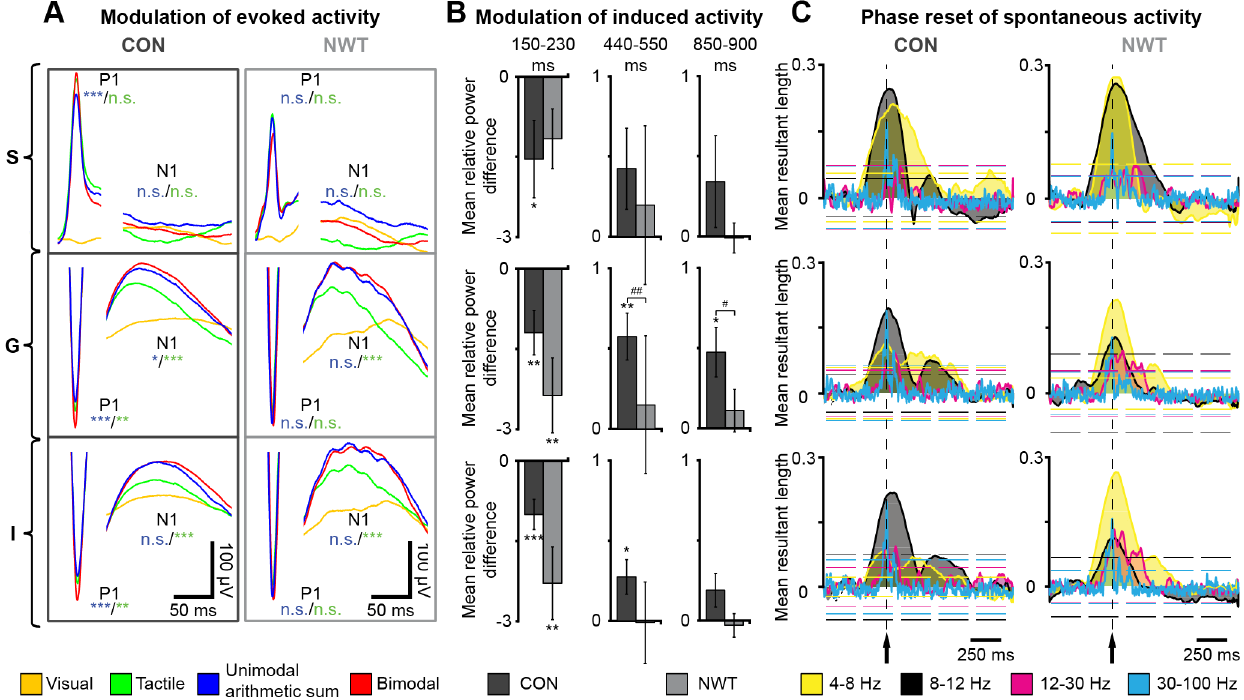
Fig 3. Cross-modal modulation of evoked and induced S1 network activity and visual phase reset of ongoing oscillatory activity in the S1 of CON and NWT rats. ( A ) Averaged potentials evoked by tactile (green), visual (orange), and bimodal (red) stimulation as well as the arithmetic sum of tactile and visual responses (blue) in the supragranular (top), granular (middle), and infragranular layers (bottom) of S1 in CON (left) and NWT rats (right). The first peak with positive surface polarity (P1) and the first negative peak (N1) are displayed. Significance values (not significant [n.s.], p < 0.05 [ * ], p < 0.01 [ ** ], p < 0.001 [ *** ]) correspond to the comparison of peak amplitudes between stimulation conditions (arithmetic sum of unimodal evoked responses versus congruent bimodal responses [blue]/tactile responses versus congruent bimodal responses [green]). ( B ) Bar diagrams displaying the mean relative power difference in gamma frequency range between bimodal and unimodal stimulation when calculated during different time windows post-stimulus in the S (top), G (middle), and I (bottom) layers of S1 in CON (black) and NWT rats (gray). Significance values correspond to the comparison between uni- and bimodal stimulation conditions ( * ) as well as between CON and NWT rats (#). ( C ) Plots displaying the mean resultant vector length of oscillatory phases in S1 of CON (left) and NWT rats (right) after contralateral visual stimulation (dotted line, black arrow). The values were averaged over time and layers in all CON and NWT rats for four distinct frequency bands: theta (4 – 8 Hz) in yellow, alpha (8 – 12 Hz) in black, beta (12 – 30 Hz) in magenta and gamma (30 – 100 Hz) in cyan. The dashed lines mark the borders of confidence interval for α = 0.01. The underlying data of this figure can be found in S1 Data. http://dx.doi.org/10.6084/m9. figshare.1540797